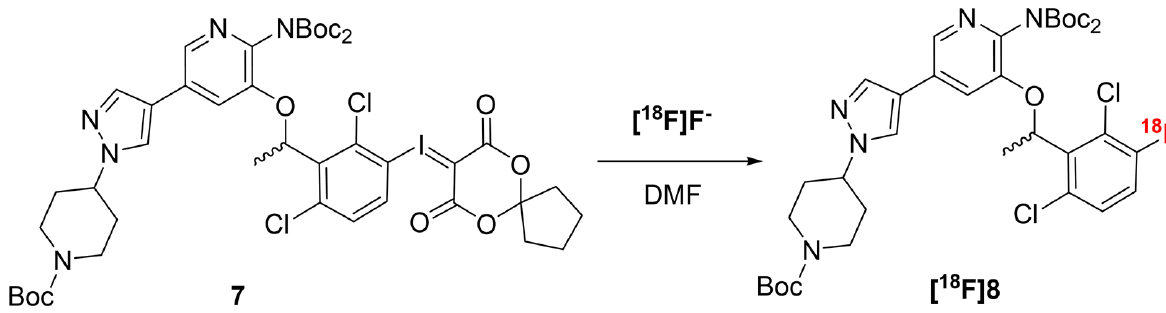
Scheme 3. Radiofluorination of 7 . The different conditions explored are depicted in Table 1. Table 1. Radiofluorination conditions explored for the synthesis of [ 18 F]8 . Table 1. Radiofluorination conditions explored for the synthesis of [ 18 F]8 . Entry 1 Base Entry 1 Base